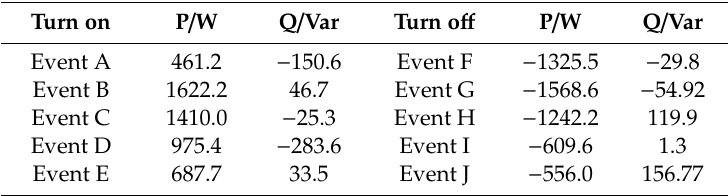
Table 6. Load characteristic information after